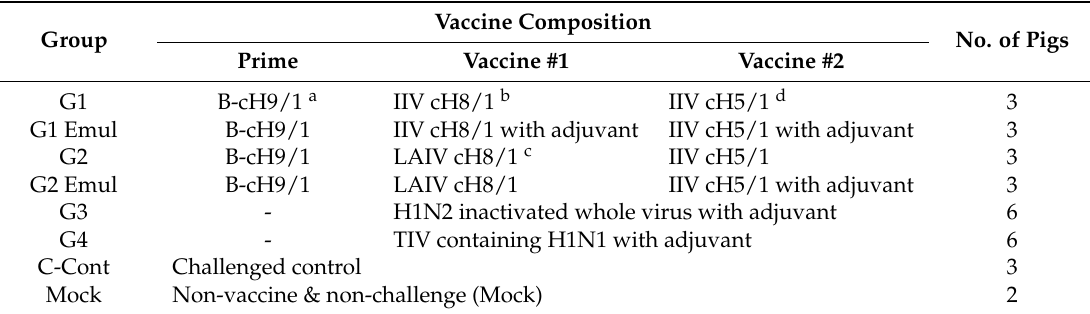
Table 1. Experimental